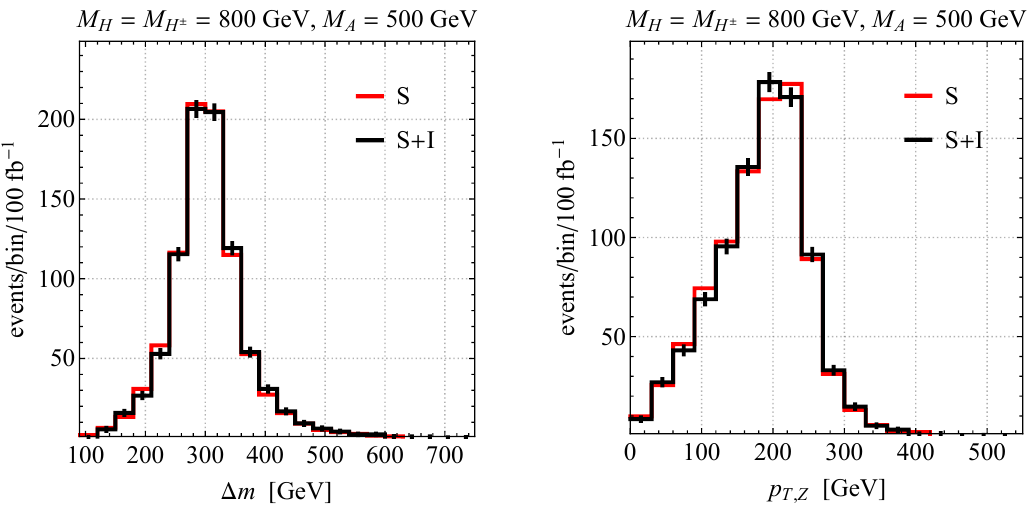
Figure 4 . Distributions of (cid:1) m (left panel) and p T;Z (right panel) of the t (cid:22) tZ signal. The shown results correspond to the type-II 2HDM and employ the parameters M H = M M A = 500 GeV, c (cid:12) (cid:0) (cid:11) = 0 and t (cid:12) = 1. The red and black curves correspond to the t (cid:22) tZ signal at p s = 14 TeV ignoring (S) and including (S+I) the interference with the SM background, respectively. The black error bars represent statistical uncertainties.